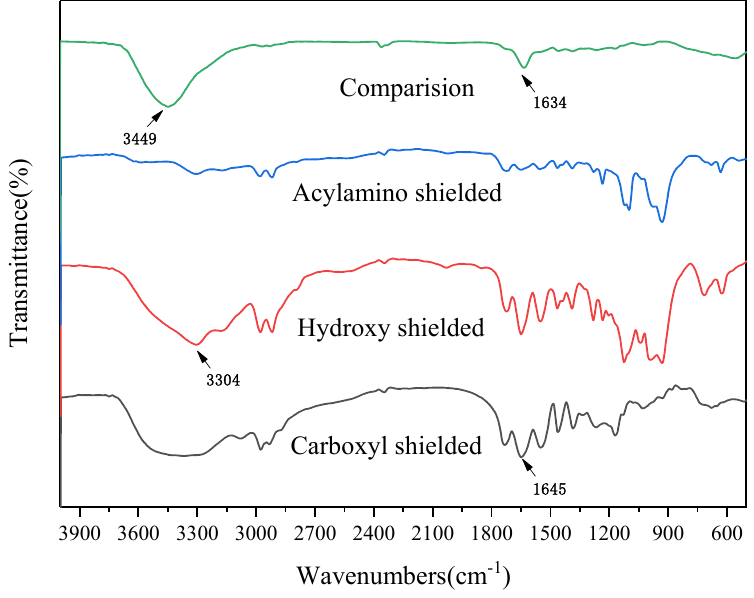
Figure 11. FTIR of CMC/P (NIPAM-co-AA) before and after the functional groups were shielded.